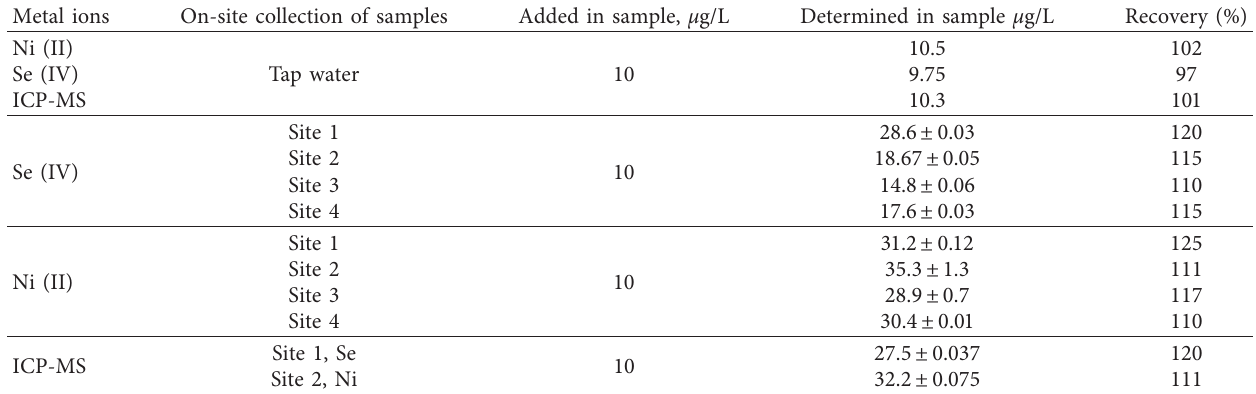
Table 2: Analytical results of real water